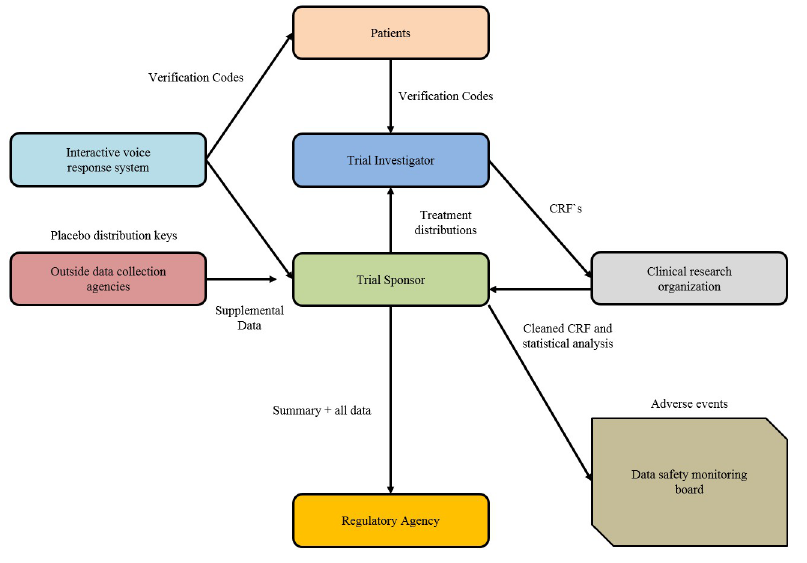
Fig 6. Role of blockchain in clinical